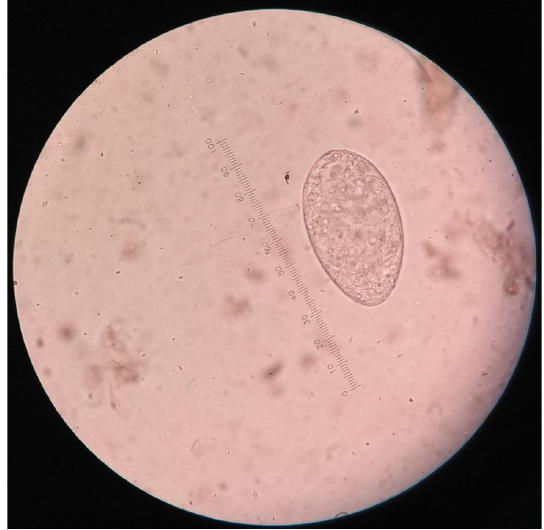
Figure 2. Photomicrograph of Fasciola egg viewed using light microscope at 400× magnification.